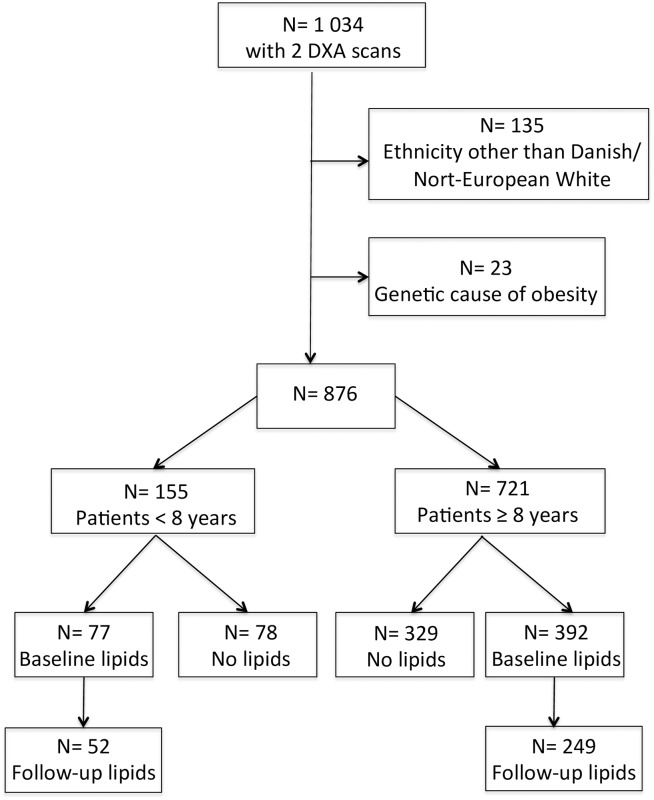
Flow-chart showing the patients in the study.